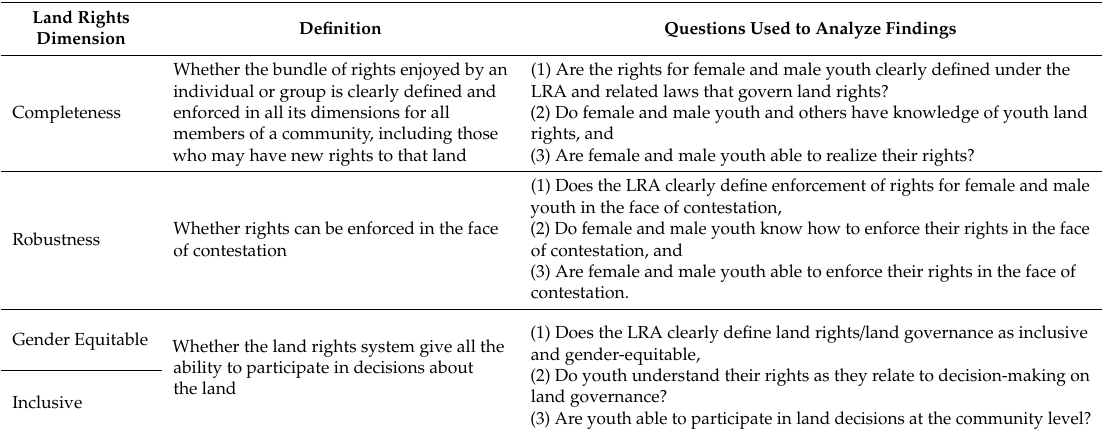
Table 2. Operationalizing a gender-responsive land rights